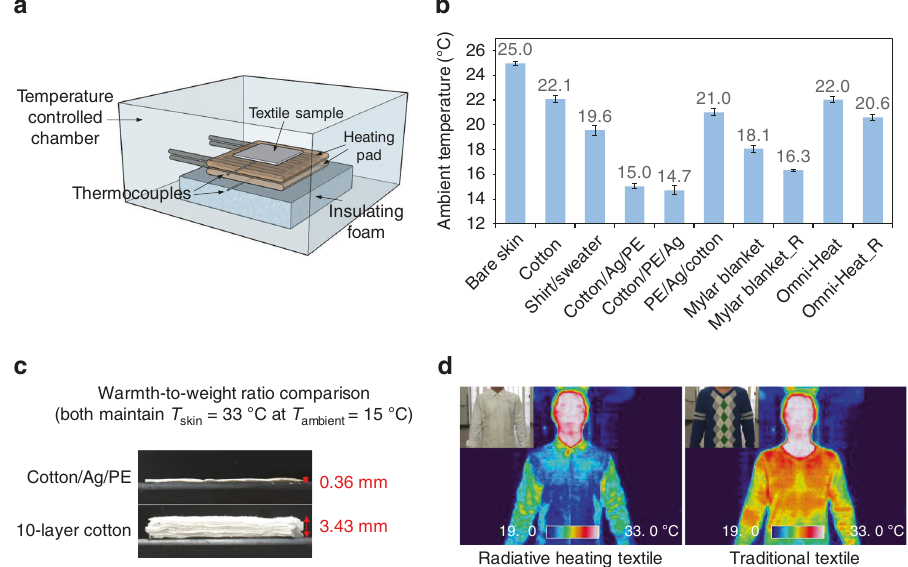
Fig. 3 Thermal performance evaluations. a Schematic representation of the thermal measurement set-up, which measures the required set-point of ambient temperature for a textile to maintain constant skin temperature at constant heat generation rate. b Measured set-points of ambient temperature for bare skin and skin covered with textile samples. In the notation of cotton/Ag/PE, cotton/PE/Ag and PE/Ag/cotton, the layer on the left is in contact with skin and the layer on the right is facing ambient environment. Mylar blanket_R and Omni-Heat_R correspond to the reversed Mylar blanket and Omni-Heat, respectively. In the reversed case, the metallic side is facing outside. For the measurements of Mylar blanket and Mylar blanket_R, a cotton layer was added below them to ensure that they have the same conductive insulation as the other tested textiles. c Comparison of warmth-to-weight ratio between cotton/Ag/PE and cotton. d Thermal imaging and photos (insets) of human body wearing garments made from radiative heating cotton/Ag/PE textile and traditional textile, respectively. All error bars represent the standard